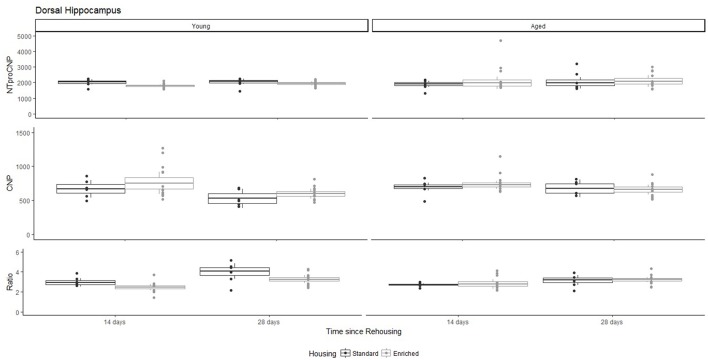
Concentration (femtomoles/g wet tissue) of NTproCNP (Top), CNP (Middle), and NTproCNP:CNP ratio (Bottom) within dorsal hippocampus. Summary data is 20% trimmed means (resulting in a reduction of n = 2 for all groups), standard error (box) and 95% confidence interval (whisker), overlaid by individual data points. For NTproCNP: Young-Enriched < Young-Standard. For CNP: Young-14-day = Aged overall > Young-28-day. For Ratio: Young-Enriched-14-day < Aged overall = Other Young rats; Young-14-day < Young-28-day.